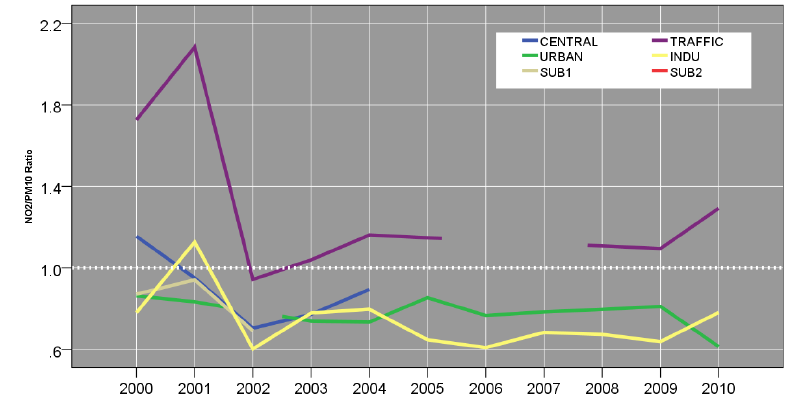
Figure 7. NO 2 /PM 10 ratio by site and